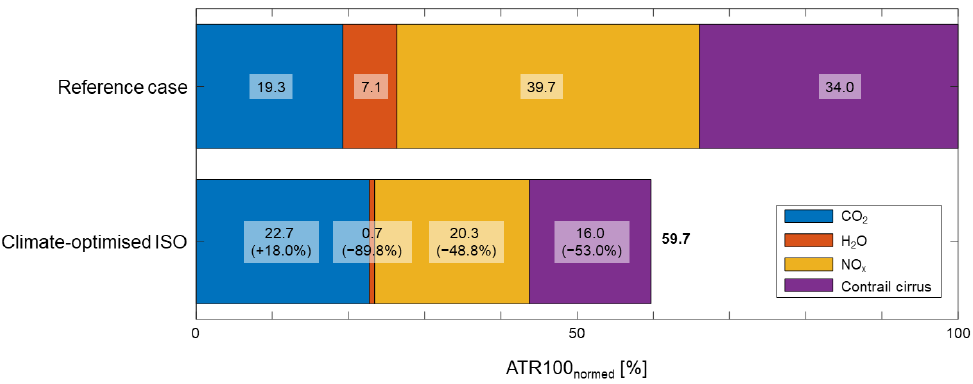
Figure 5. Change in ATR100 per emission species for climate-optimised ISO compared to the non-stop reference